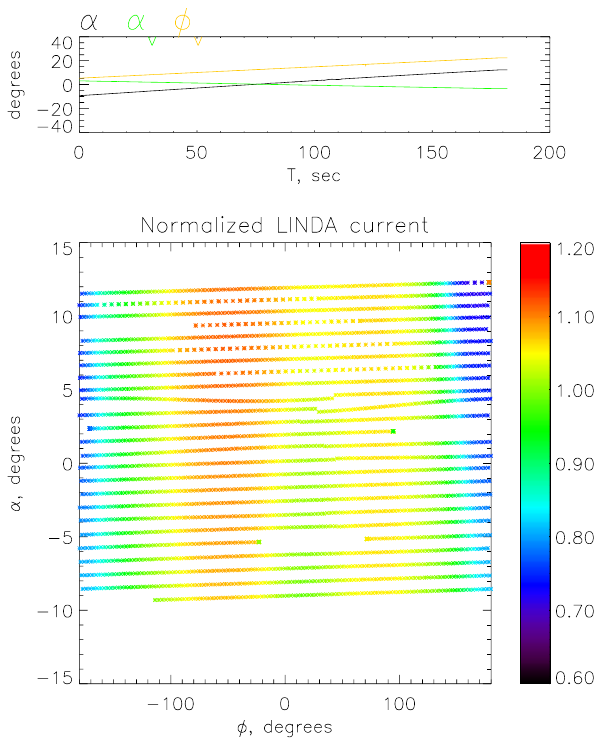
Fig. 9. Map of the current collected by LINDA probe n 2 (normal- ized) in (φ,α) coordinates. In this figure φ = 0 ◦ corresponds to LINDA n 2 probe boom being parallel to B .